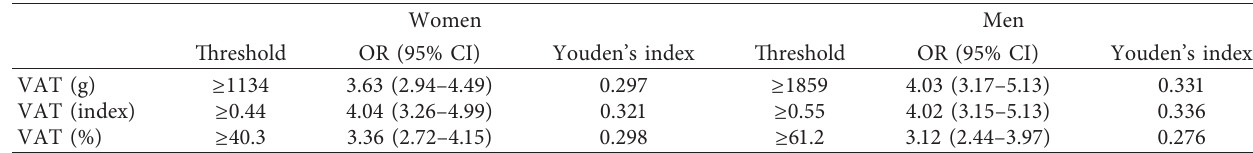
Table 5: Suggested threshold values of VATderived from Youden’s index and odds for metabolic syndrome: the Tromsø Study